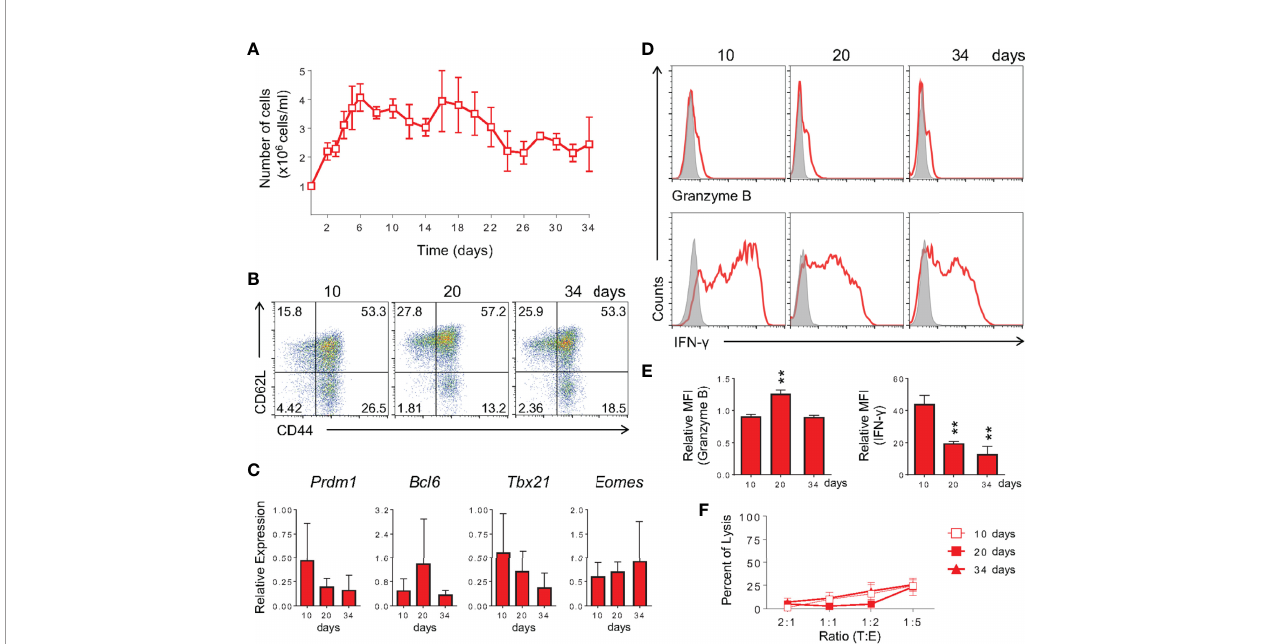
FIGURE 5 | Memory CD8 T Cells Differentiated In Vitro Are Long-Lived. (A) Memory CD8 T cell cellularity along 34 days of culture. Cells were cultured as described in Figure 1 until day 10, at which point IL-2 and IL-15 were added every other day until analysis. The number of cells was quanti fi ed by trypan blue exclusion. (B) Analysis of expression of anti-CD44 and anti-CD62L by in vitro memory cells at the 10 th , 20 th and 34 th days of culture. (C) Real-time RT-PCR assay analysis using TaqMan probe for Prdm1 , Bcl6 , Tbx21 and Eomes genes. The data were normalized to the Hprt housekeeping gene and compared with the lowest memory Ct mean at day 10. (D, E) Cells were challenged with PMA and ionomycin for 6 h and ICC stained for IFN- g and granzyme B detection. The relative MFI was obtained from its respective isotype control MFI normalization. (F) Anti-CD3 dependent cytotoxicity assay of in vitro -generated memory cells at 10 (square), 20 ( fi lled square) and 34 (triangle) days of culture. All data are shown as the mean ± SD. The (**) indicates p < 0.01 compared with day 10 th . All results are representative of three independent experiments. Ctrl: Mouse IgG2a isotype control (gray); memory (red).